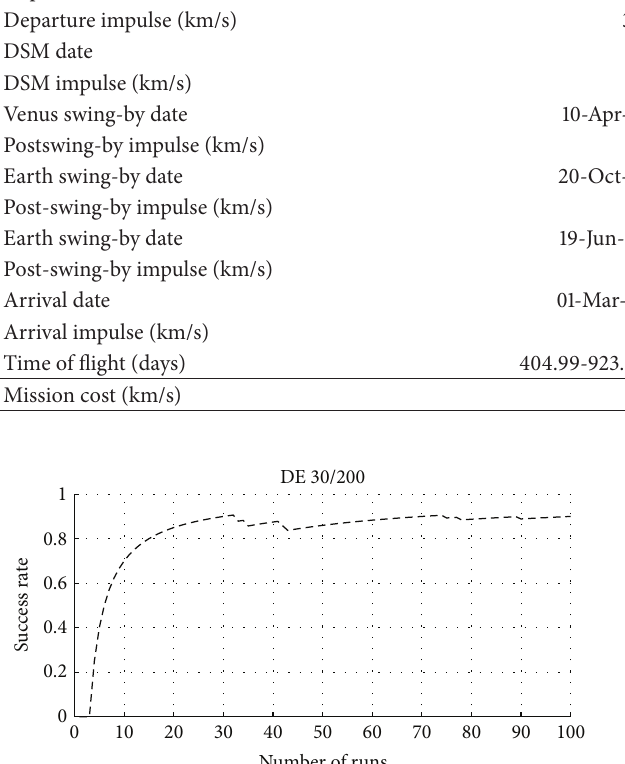
Figure 4: Zero-DSM case: Cost success rate.